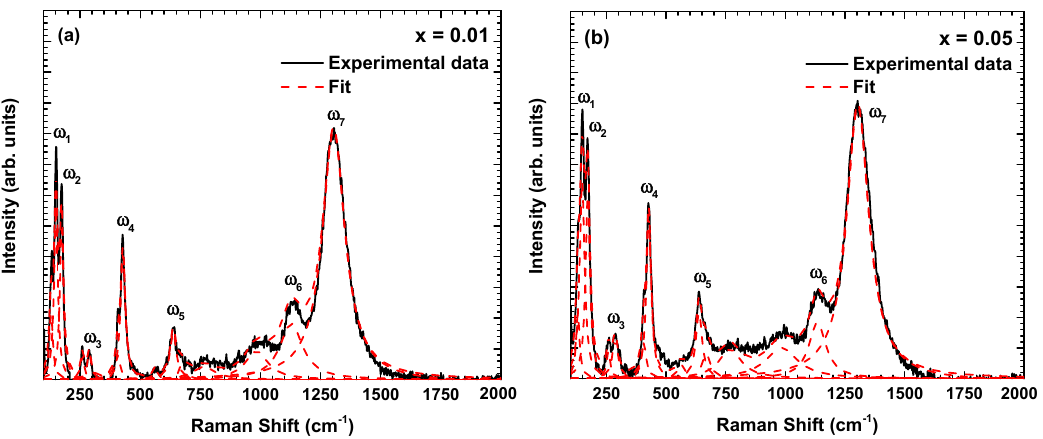
Figure 2. Raman scattering spectra of LaFe 1 − x Zr x FeO 3 ceramics with ( a ) x = 0.01, and ( b ) x = 0.05 at room temperature. Table 4. Frequency and symmetry assignment of some specific Raman-active phonon modes ( ω )